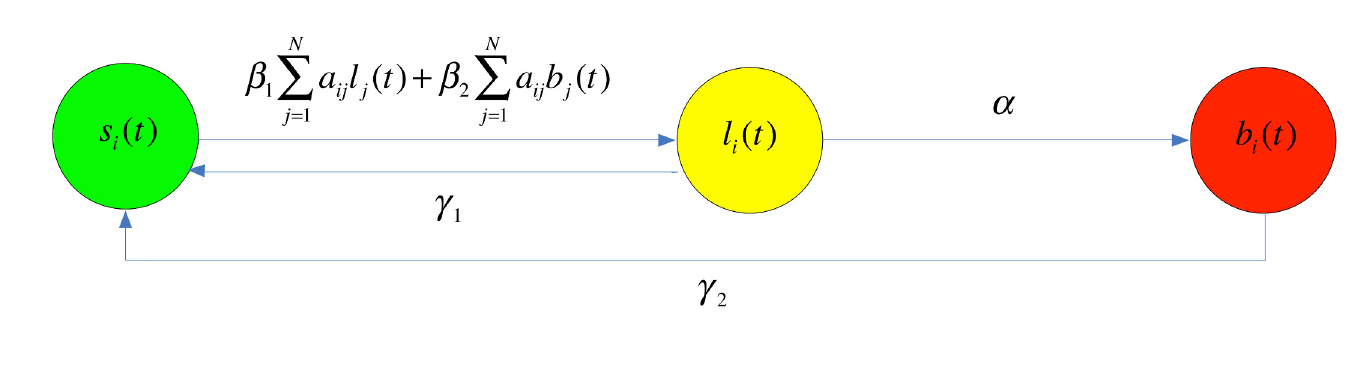
Fig 1. Diagram of assumptions